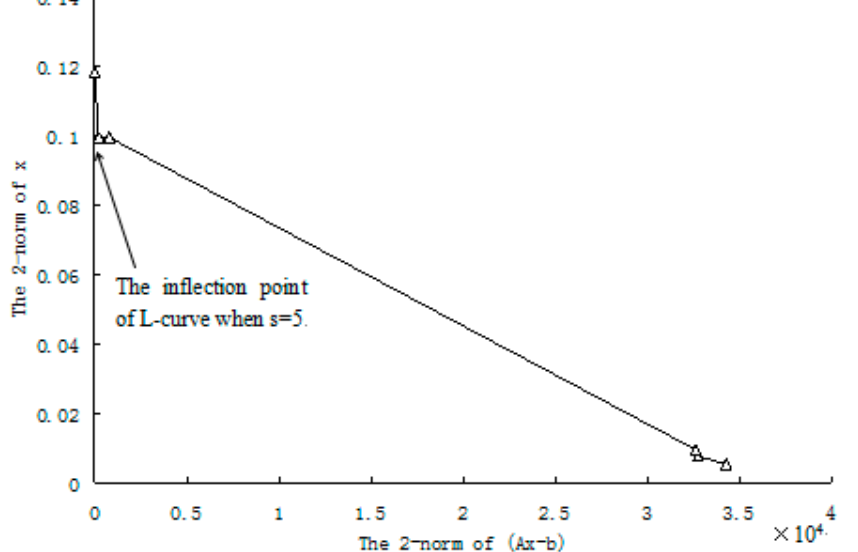
Figure 2. The L-curve used to determine the number of remained singular values in singular value truncation (SVT) for case 1.